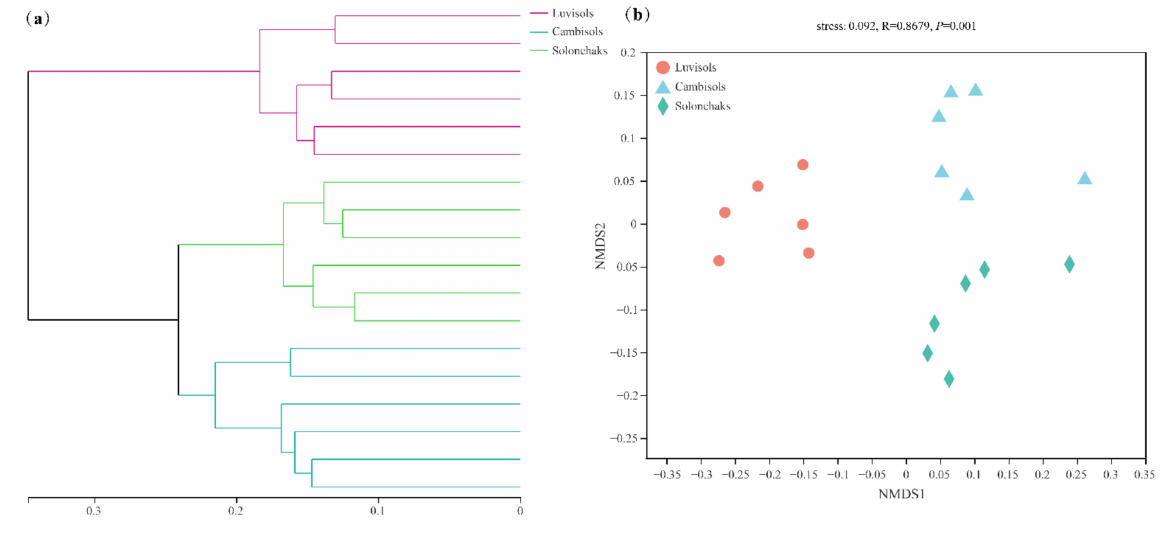
Figure 2. Beta diversity analysis of rhizosphere bacteria in different soil types of pecan plantations. ( a ) Hierarchical clustering tree represents the distance of sample branches. ( b ) NMDS and ANOSIM reflect differences and distances of samples. The stress value is used to test the quality of NMDS analysis results, and the ranking of results is better when stress <0.1. The R and p values represent the results of ANOSIM analysis.